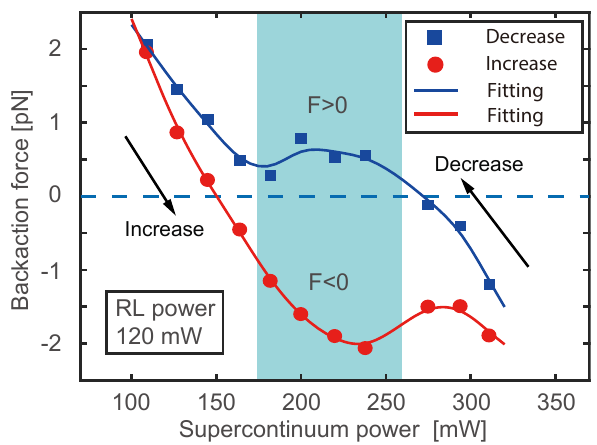
Figure 5: Reversible backaction force on the polystyrene microsphere of 10 μ m diameter controlled by hysteresis. The backaction force changes with the direction of power change of the supercontinuum source, while the counter-propagating Raman laser with wavelength of 1.65 μ m was fixed at a power of 120 mW. Blue squares and red circles demonstrate the experimental measurement when the power of the supercontinuum beam reduces and increases respectively. The blue and red solid lines show the